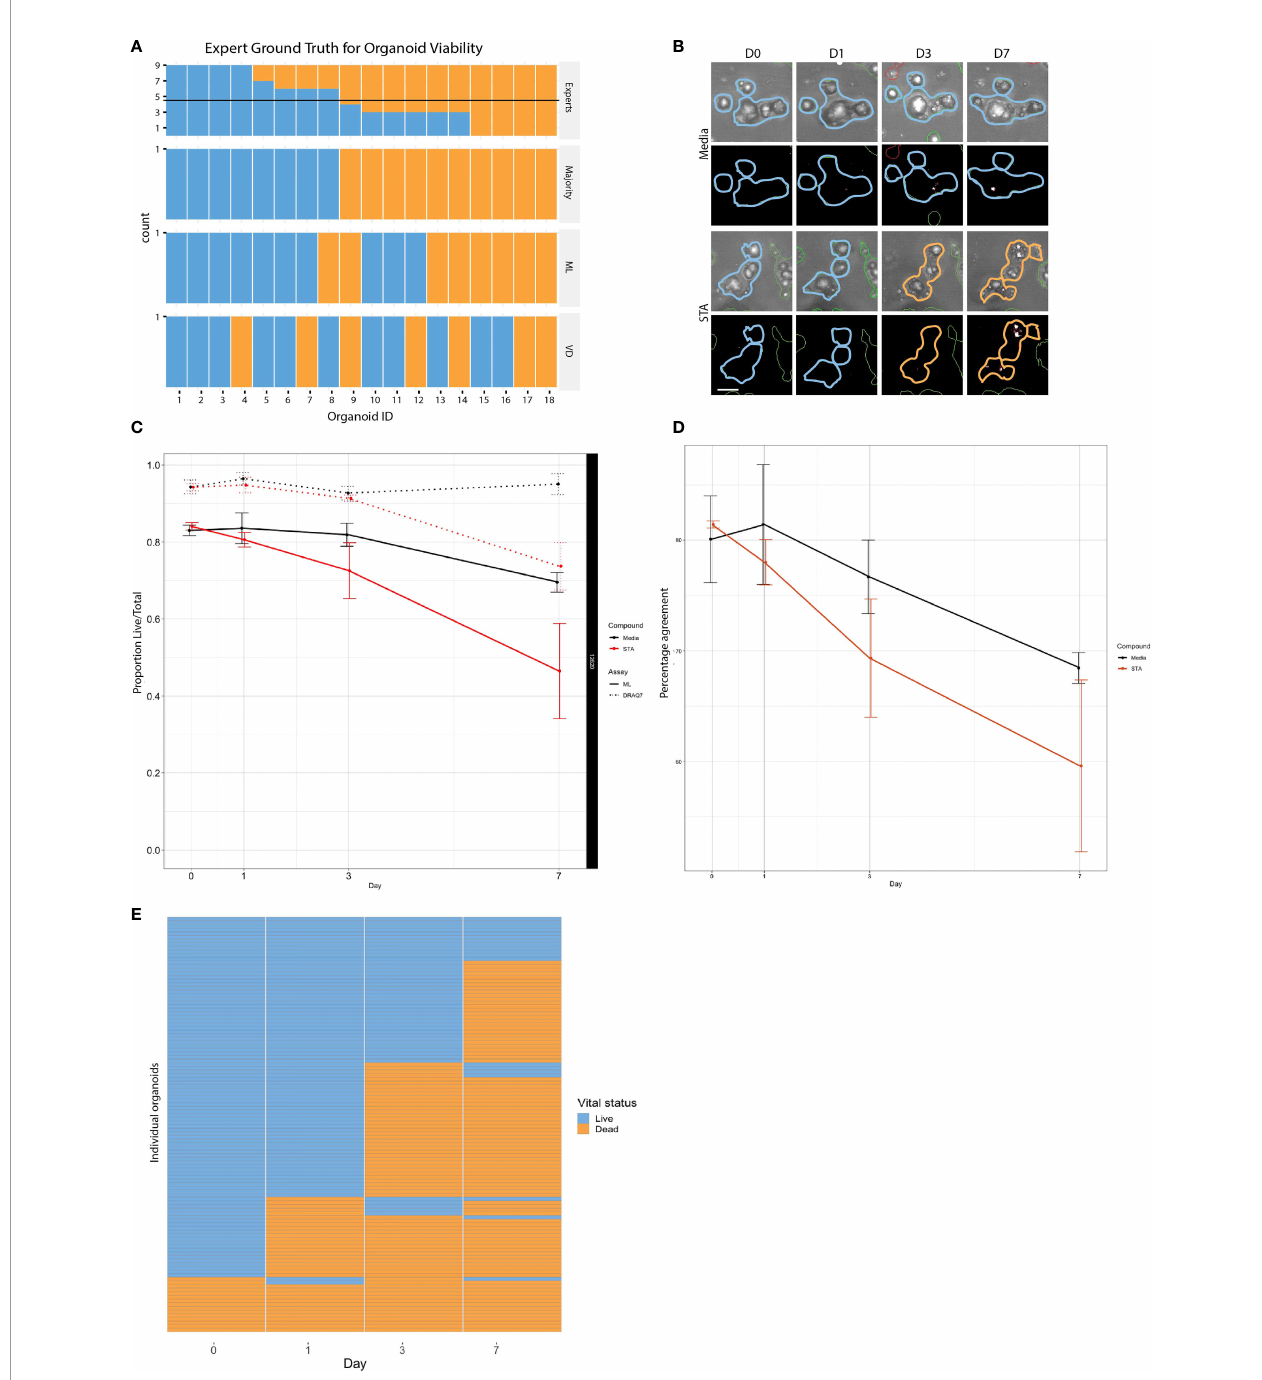
FIGURE 3 | Comparison of live and dead classi fi cation by ML and vital dye. (A) Classi fi cation of 18 different organoid images as either live or dead was determined using three independent methods: tissue culture experts, ML, and DRAQ7, and then compared to determine level of concordance. (B) PDOs treated with staurosporine or untreated controls stained with DRAQ7 and classi fi ed by ML. Scale bar is 50µm. (C) The normalized proportion of live/total organoids (PDO 12620) for the control and staurosporine treated group as determined by both ML and DRAQ7 was plotted over the course of 7 days (error bars: SD of 3 replicate wells per group per timepoint). When classi fi ed by ML the difference in response between the treated and untreated groups are seen starting on day 1, whereas VD classi fi cation does not start to show separation until after day 3. (D) Percentage agreement of ML and DRAQ7 live/dead classi fi cation for untreated and staurosporine treated organoids (PDO 12620; error bars are SD of 3 replicate wells each). (E) Tracking the vital status of individual organoids (PDO 13154) over 7 days treatment with staurosporine as assessed by our ML classi fi cation (N=114